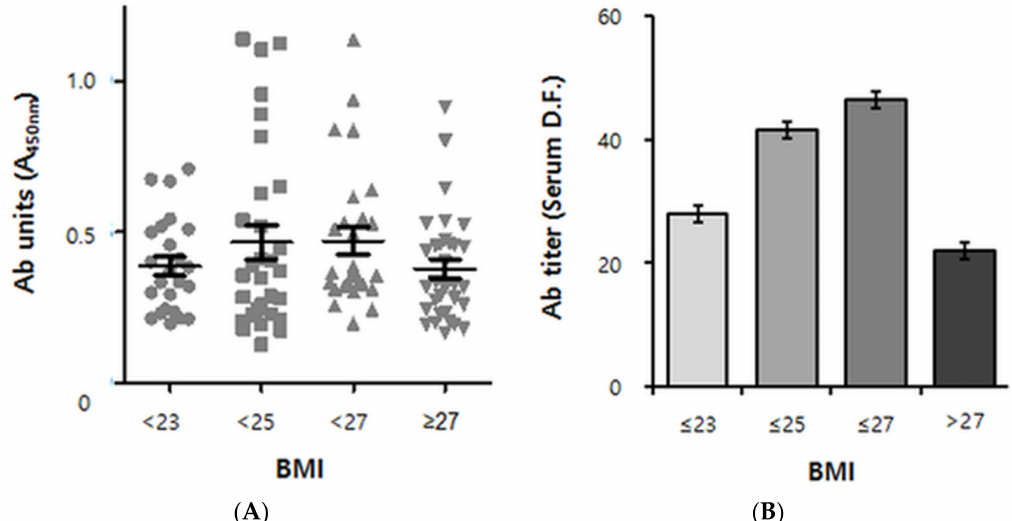
Figure 3. Cross-sectional analysis of human anti-pB1 antibody titer data versus BMI. ( A ) Scatterplot derived from 107 positive samples (out of 148 human volunteers of South Korean nationality) according to the BMI group. BMI < 23: lean, 23 ≤ BMI < 25: overweight, 25 ≤ BMI < 27: obese, 27 ≤ BMI: severely obese. n = 23, 26, 27 and 31, respectively. Ab (antibody) units indicate the absorbance of × 100 diluted sera at 450 nm. Error bars indicate means ± s.e.m. ( B ) Quadratic Trend Analysis of data shown in A. Antibody titers refer to serum dilution folds (D.F.) yielding an absorbance read-out of 0.5 (See “Supplementary Materials” for a detailed explanation). The association between autoantibody titers and the BMI group was adjusted for age and sex. The P value for quadratic trend was 0.0494 ( p < 0.05). Error bars indicate geometric means ±